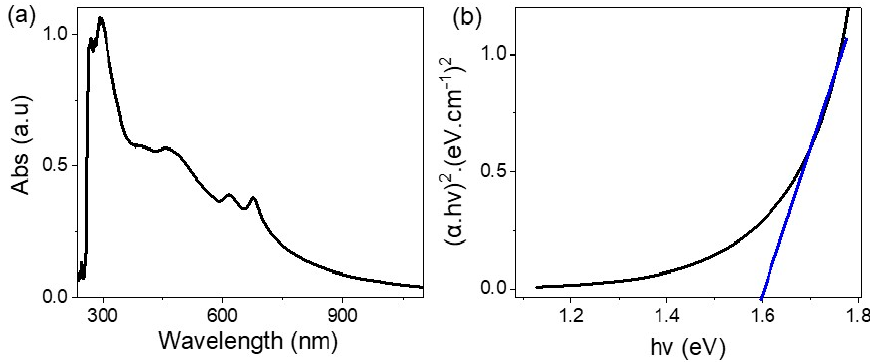
Figure 5. ( a ) Absorbance and ( b ) bandgap of 2D MoS 2